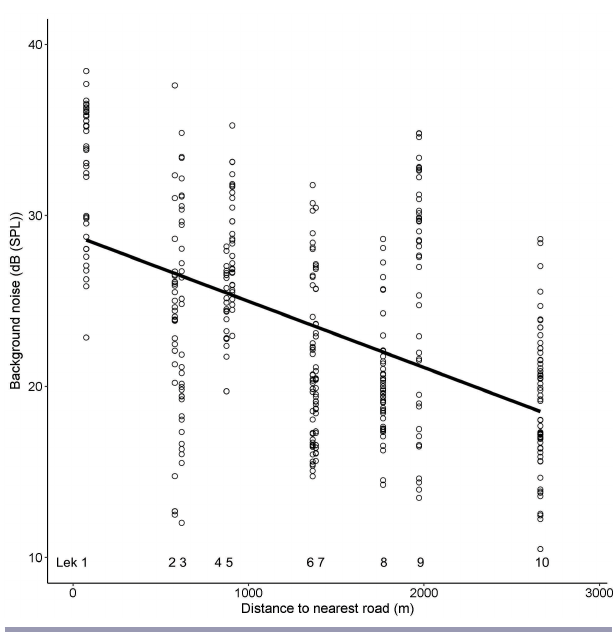
Fig. 2 . Background noise at ~0.300 kHz from 10 Greater Prairie-Chicken ( Tympanuchus cupido ) leks with different proximities to roads near Ainsworth, Nebraska, USA and used as lek-specific background noise input in the sound propagation model. Each column of points represent lek- specific background noise values recorded during boom chorus events. Leks are plotted in ascending order of distance from road with lek 1 being 76 m from a road and lek 10 being 2664 m from a road. Leks 1, 4, and 5 were located closest to the wind energy